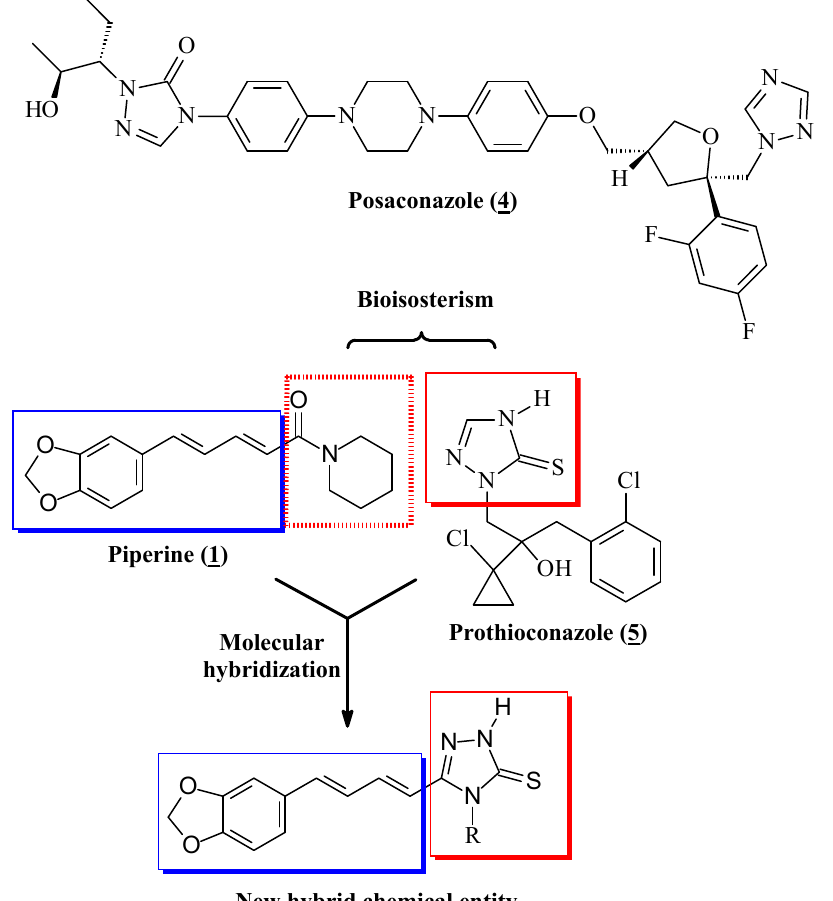
Figure 2. Strategies on the designing of new piperine-triazole